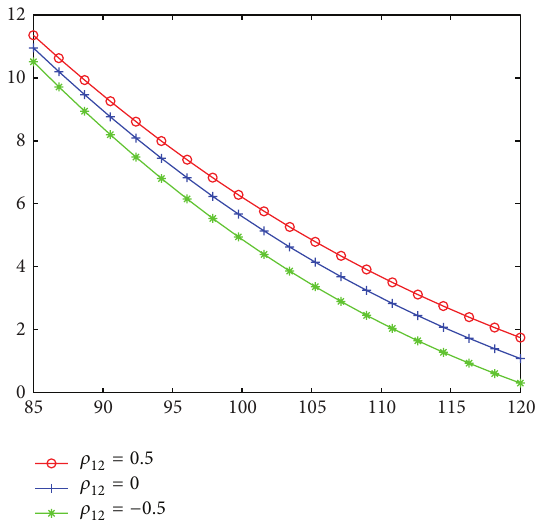
Figure 4: The influence of covariance 𝜌 12 .